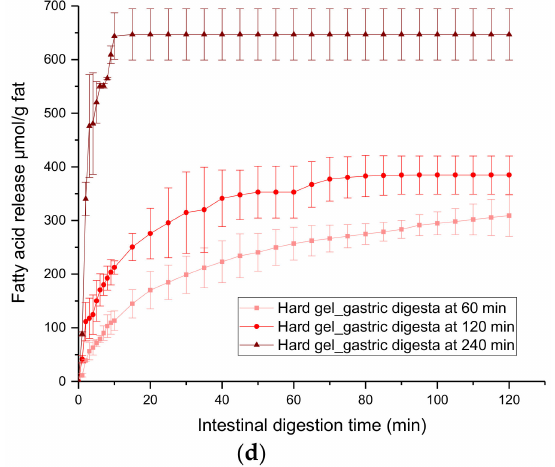
Figure 5. Free fatty acid release profile per mL of digestion mixture of gastric digesta emptied at 60, 120 and 240 min from: ( a ) soft gel, ( b ) hard gel. Free fatty acid release profile per gram of fat of gastric digesta emptied at 60, 120 and 240 min from: ( c ) soft gel; ( d ) hard gel. Error bars represent standard deviations obtained from three